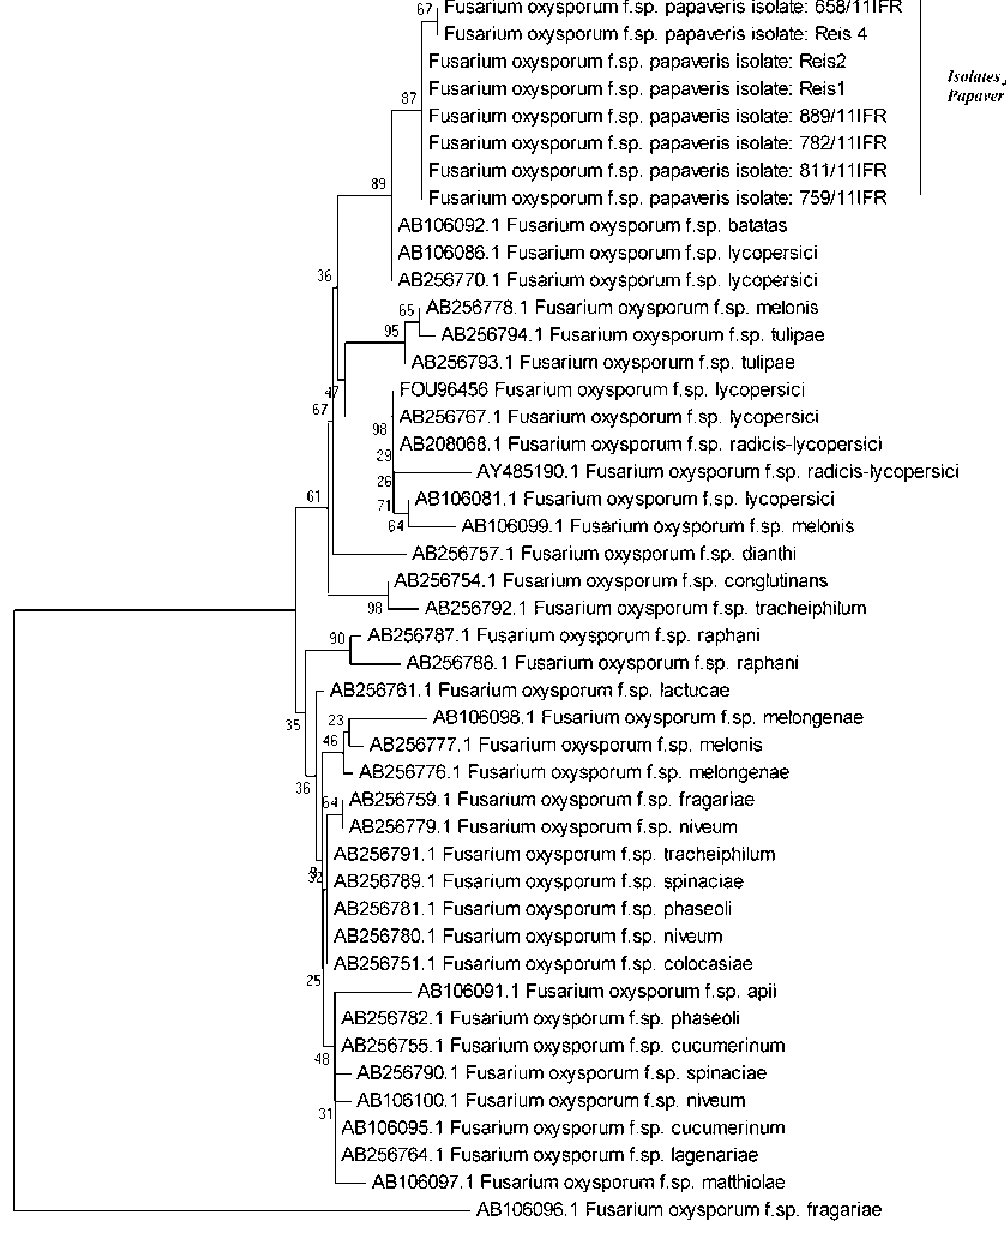
Figure 2. Phylogenetic tree based on Pg1 gene sequences built by Mega5 software with Neighbor joining method; bootstrap values from 1000 replicates are shown at the